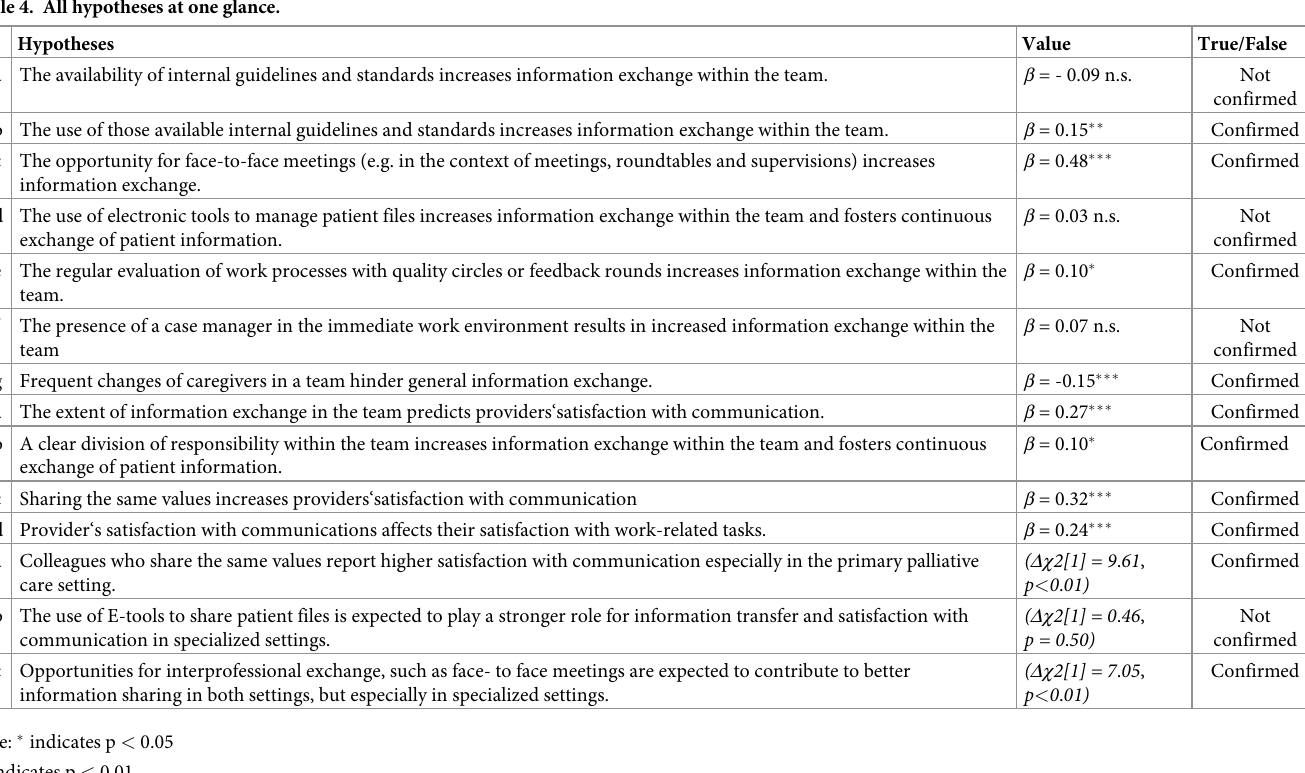
Table 4. All hypotheses at one